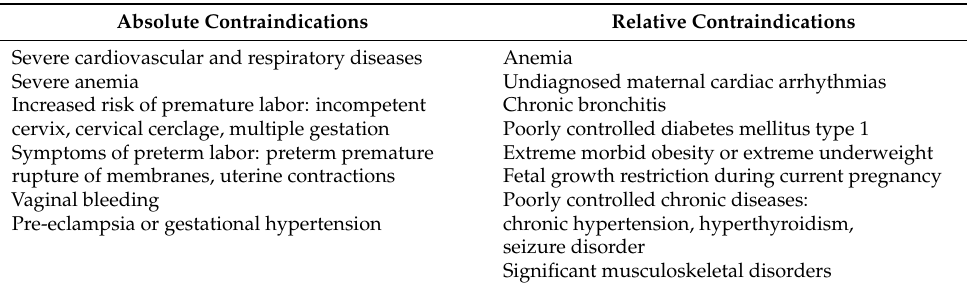
Table 5. Contraindications to exercise in